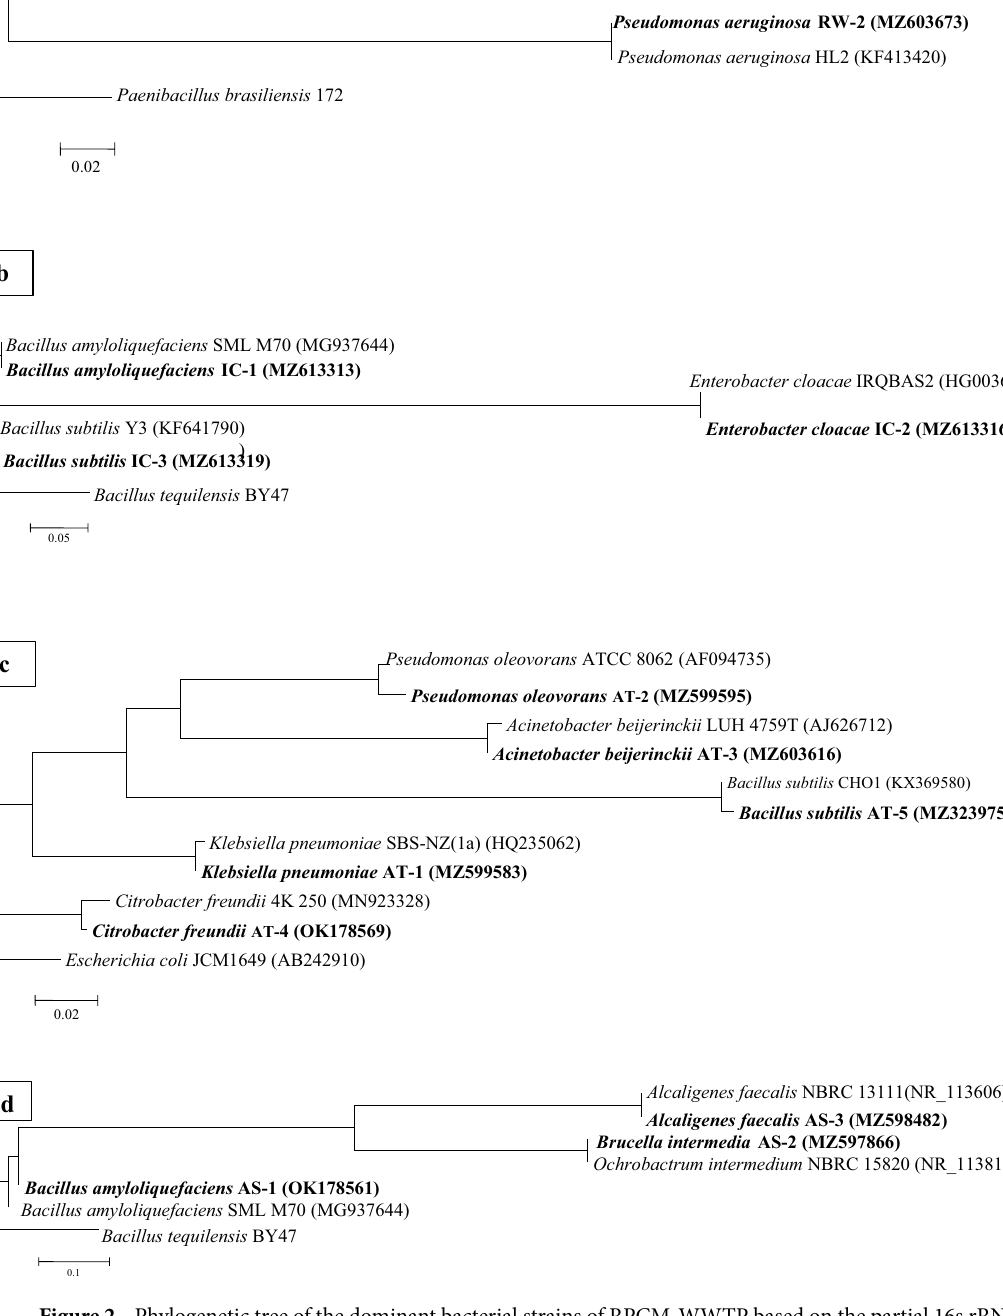
Figure 2. Phylogenetic tree of the dominant bacterial strains of RPCM-WWTP based on the partial 16s rRNA gene sequence representing the relationship between other neighboring members (the Genbank accession numbers were exhibited in parenthesis): ( a ) raw wastewater, ( b ) IC reactor, ( c ) oxidation ditch, and ( d ) return activated sludge. Note . RPCM: Recycled paper and cardboard mill; WWTP: Wastewater treatment plant; IC: Internal